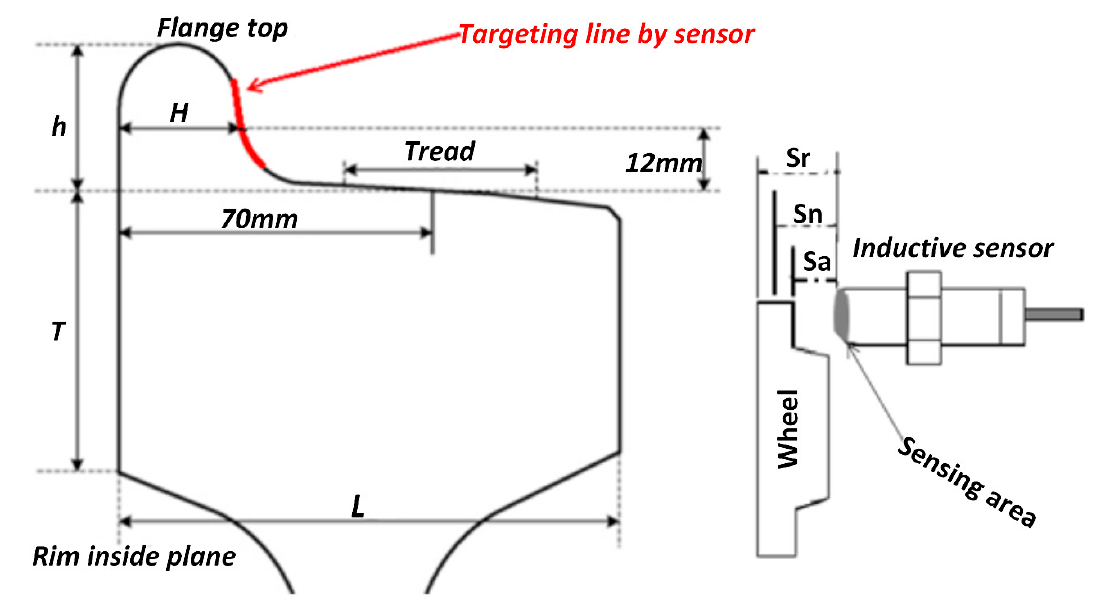
Figure 2. Detected object and sensor characteristics.